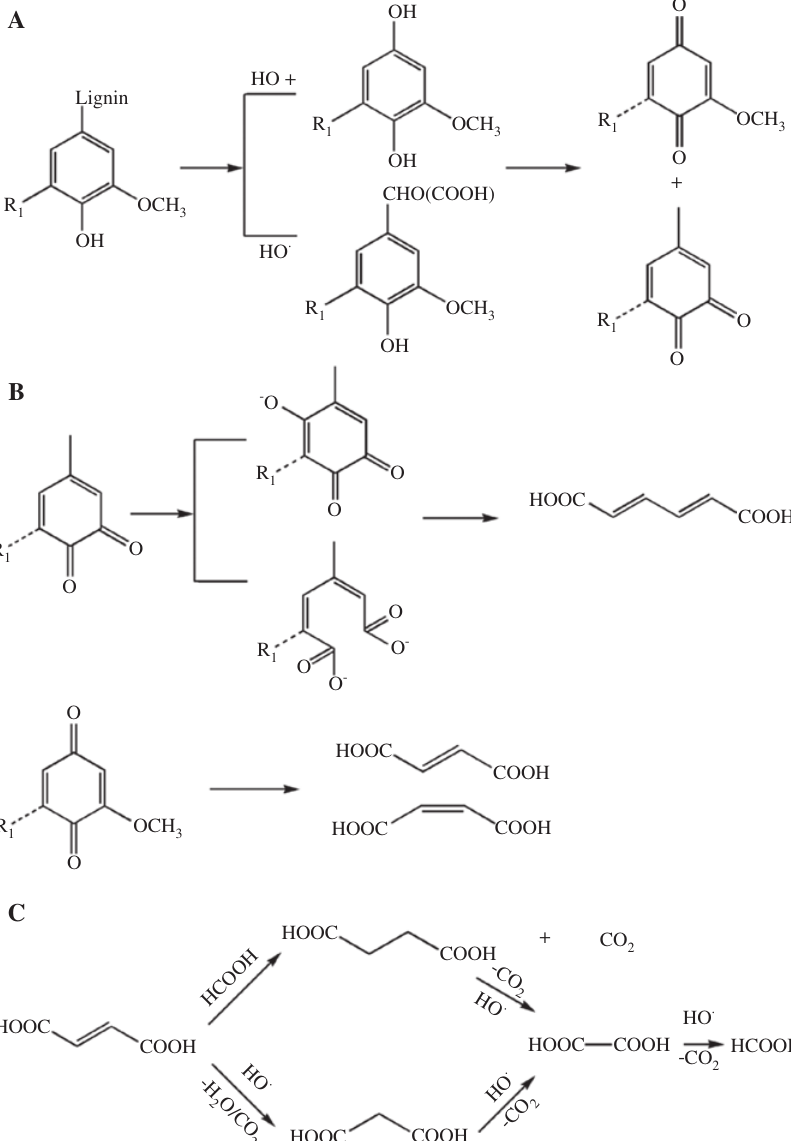
Scheme 2: Possible degradation mechanism of lignin over the CuFeS